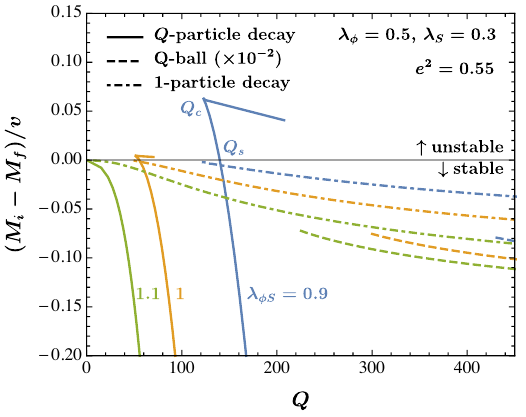
Figure 2 . Difference between the initial and final masses M i and M f (normalized to v ) for the Q -particle (2.3), Q-ball (2.4), and 1-particle (2.5) decay channels shown solid, dashed, and dotted, respectively. Different colors denote different choices of λ φS ; the other parameters are fixed, in- cluding m S, 0 = 0 . Values greater than zero are unstable; the charge at which the Q-particle decay crosses zero is denoted Q s in the text. When curves are cut off on the left, no solution exists for the QMB (solid and dotted curves) or for the isolated Q-ball (dashed curve), denoted Q c in the text. Two different-mass and same-charge solutions exist; part of the higher-energy solution for the QMB is shown in the solid curves. The Q-ball decay channel (dashed) has been multiplied by 10 − 2 on the y-axis to make it visible in the plot